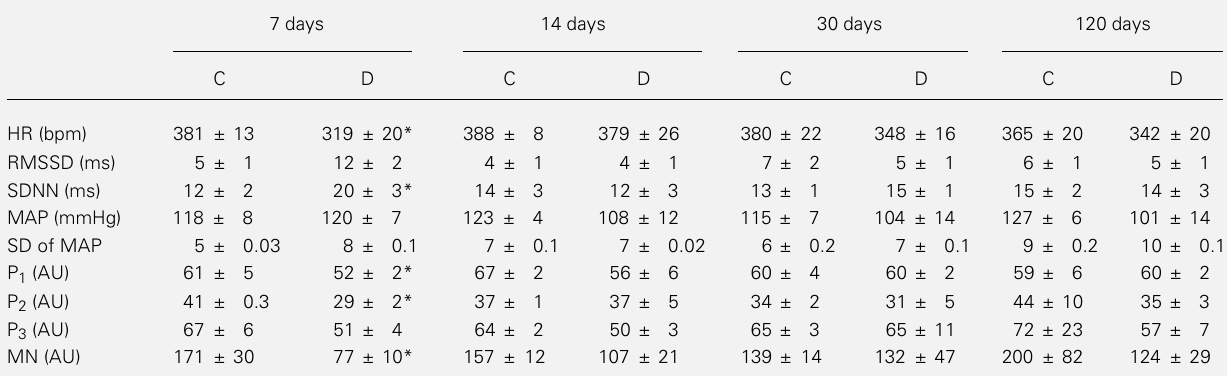
Table 1 - Cardiovascular characterization of diabetic (D) and control (C) rats 7, 14, 30 and 120 days after streptozotocin injection. Data are reported as means ± SEM. *P £ 0.05 vs control rats (Mann-Whitney U-test). HR = Heart rate; RMSSD = root mean square of successive difference of RR intervals; SDNN = standard deviation of the normal RR intervals; MAP = mean arterial pressure; SD = standard deviation; AU = arbitrary